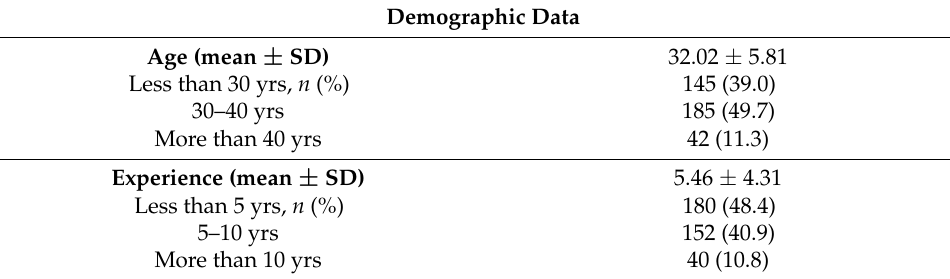
Table 1. Demographic data of the community